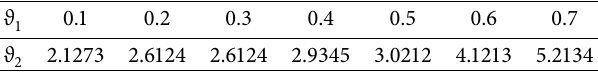
Table 1: Maximum allowable bounds of ϑ lower bound ϑ for Example 1